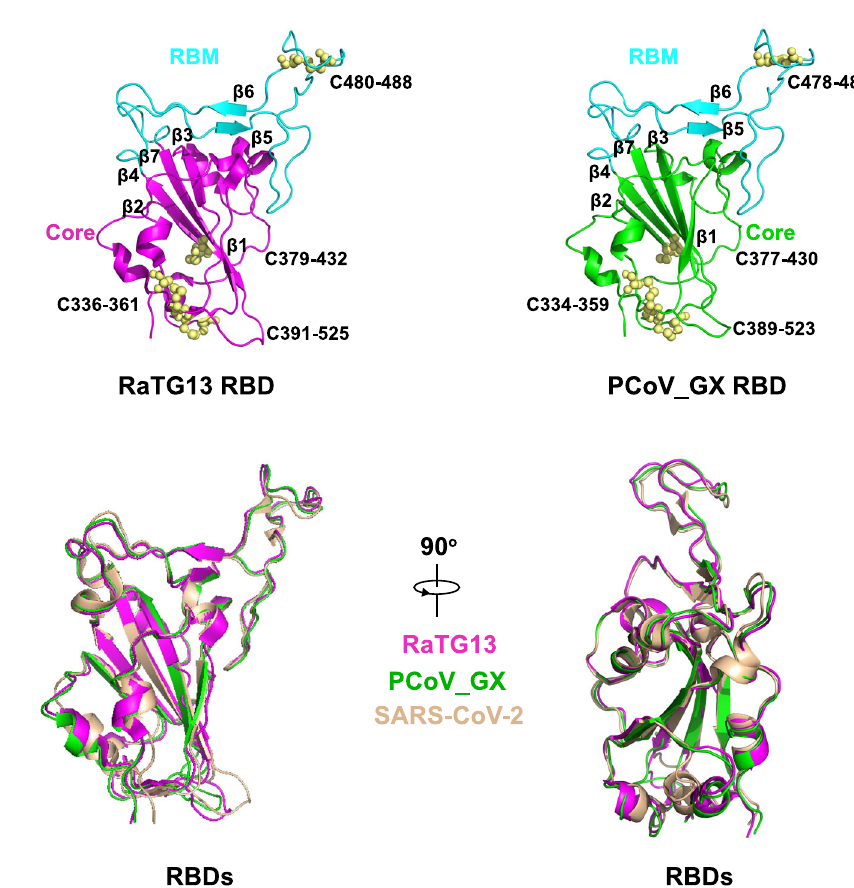
Fig. 2 RBD structures of the RaTG13 and PCoV_GX spike proteins. a The RaTG13 and PCoV_GX RBDs are shown in side view. The RaTG13 RBD core is colored in magenta and the RBM in cyan; the PCoV_GX RBD core is colored in green and the RBM in cyan. Disul fi de bonds are shown as yellow spheres with residues labeled. b Structural alignment of the RaTG13, PCoV_GX, and SARS-CoV-2 (PDB ID: 6M0J) RBDs. The RaTG13 RBD is colored in magenta, the PCoV_GX RBD is colored in green, and the SARS-CoV-2 RBD is in wheat. Aligned structures are shown in two